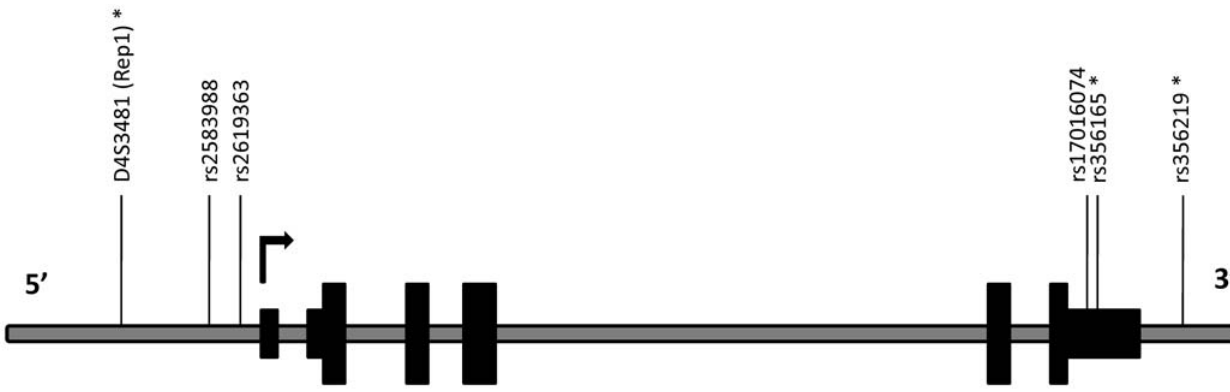
Figure 2. A schematic representation of the human SNCA gene with the relative positions of the markers. Organization of the human SNCA locus: translated exons, wide black solid boxes; 5 9 and 3 9 UTR, narrow black solid boxes; introns and intergenic regions, grey line. The relative positions of the genetic variants are indicated above, asterisks designate variants that were associated with SNCA -mRNA.